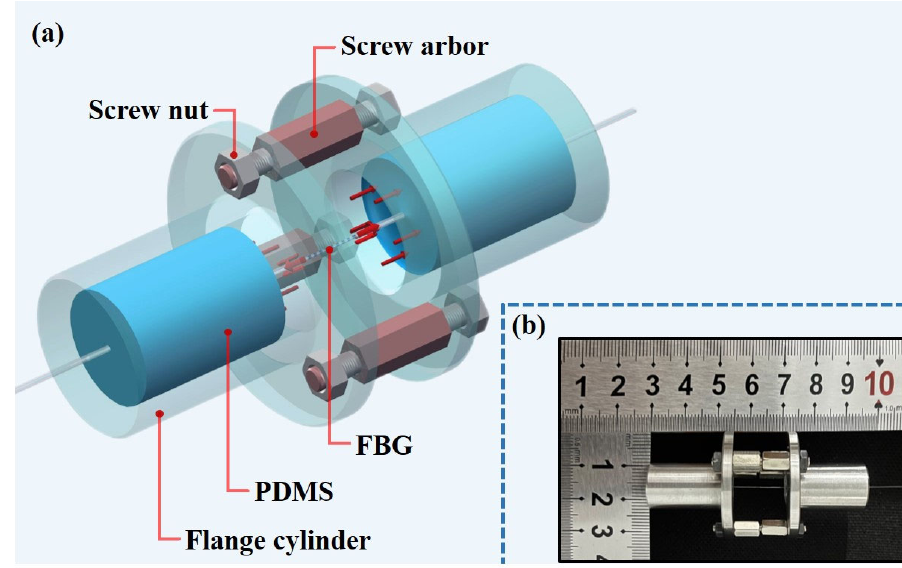
Figure 3. Sensor structure: ( a ) 3D schematic diagram of the sensor; ( b ) sensor prototype.